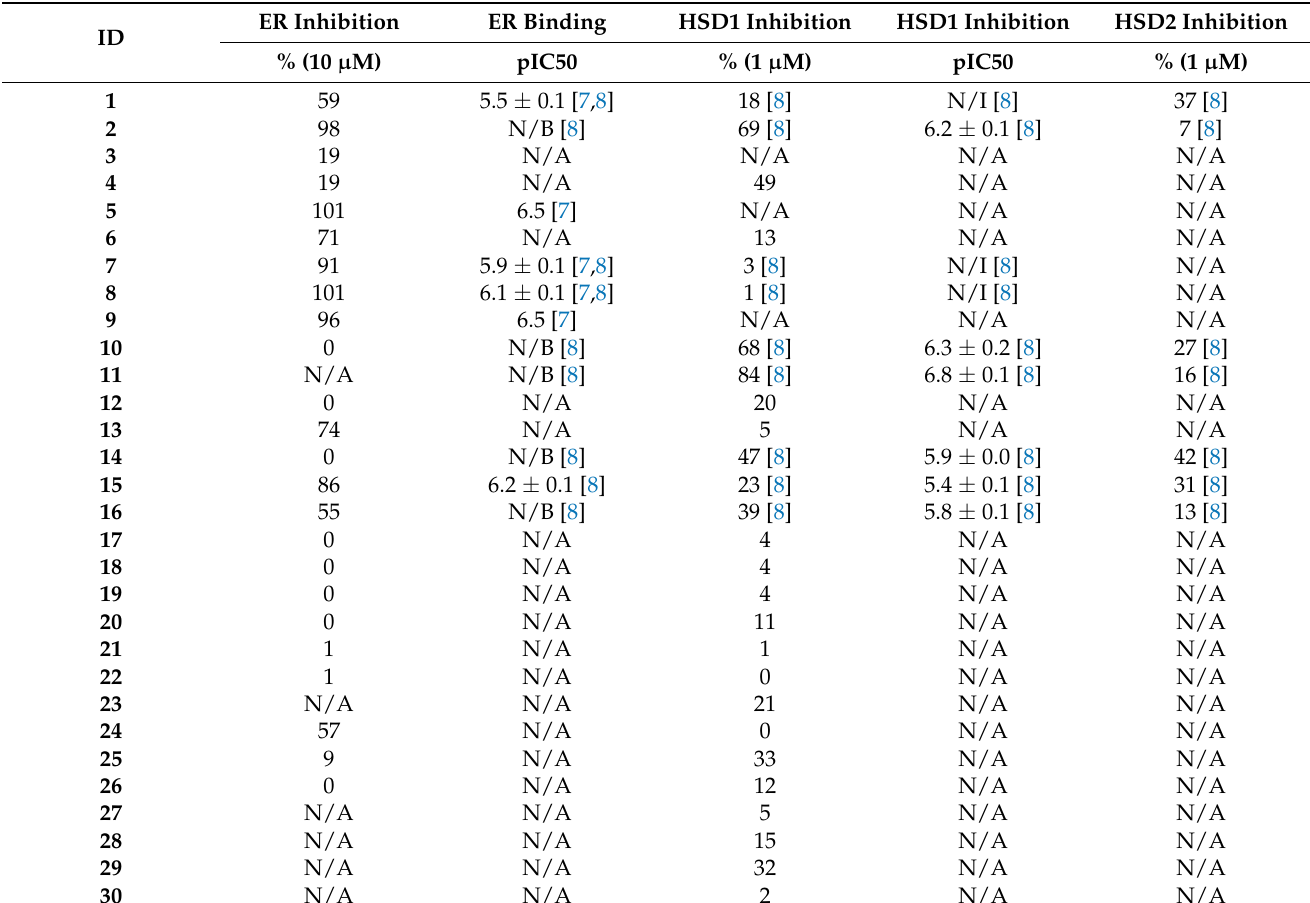
Table 1. Inhibitory profiles of the 3-phenylcoumarin compounds